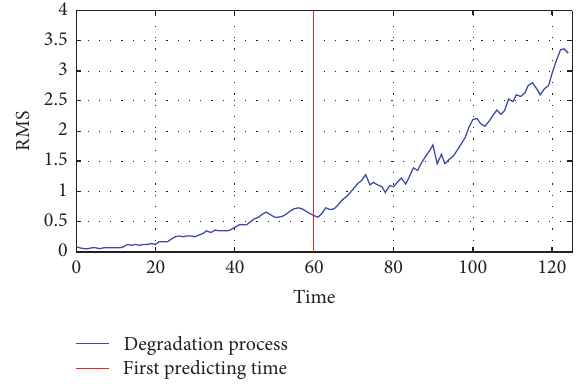
Figure 1: Degradation process and first predicting